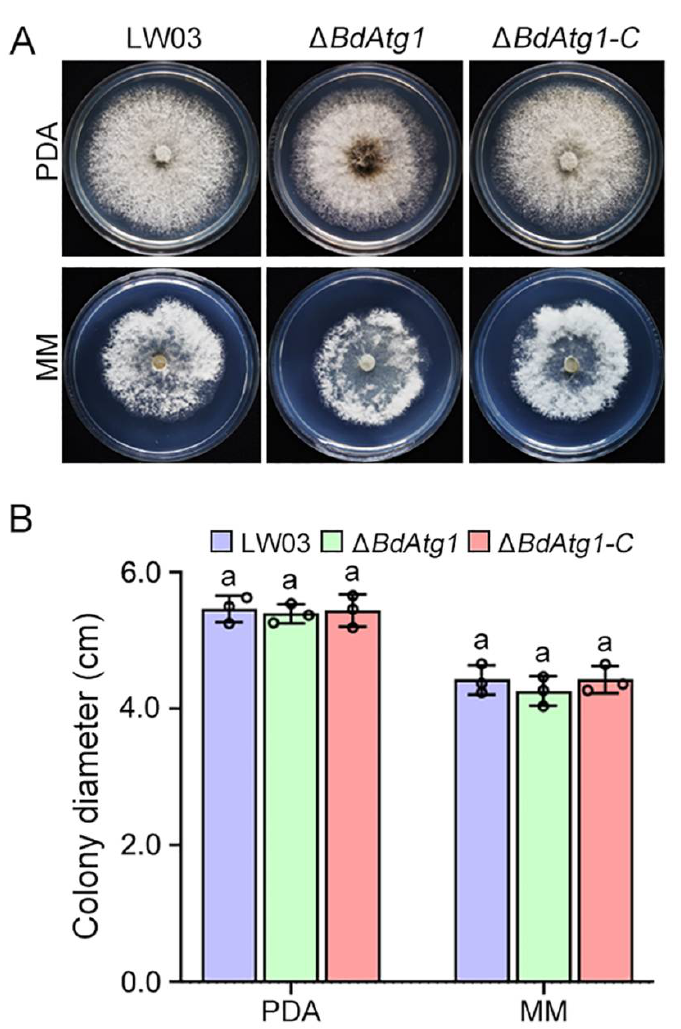
Figure 3. BdAtg1 is involved in mycelial growth. ( A ) Strains of B. dothidea were grown on PDA and MM media at 25 °C for 3 days. ( B ) Mycelial growth rate of each strain on PDA and MM media. Error bars indicate standard deviation from three independent experiments. Values on the bars followed by the same letter are not significantly different at p = 0.05.